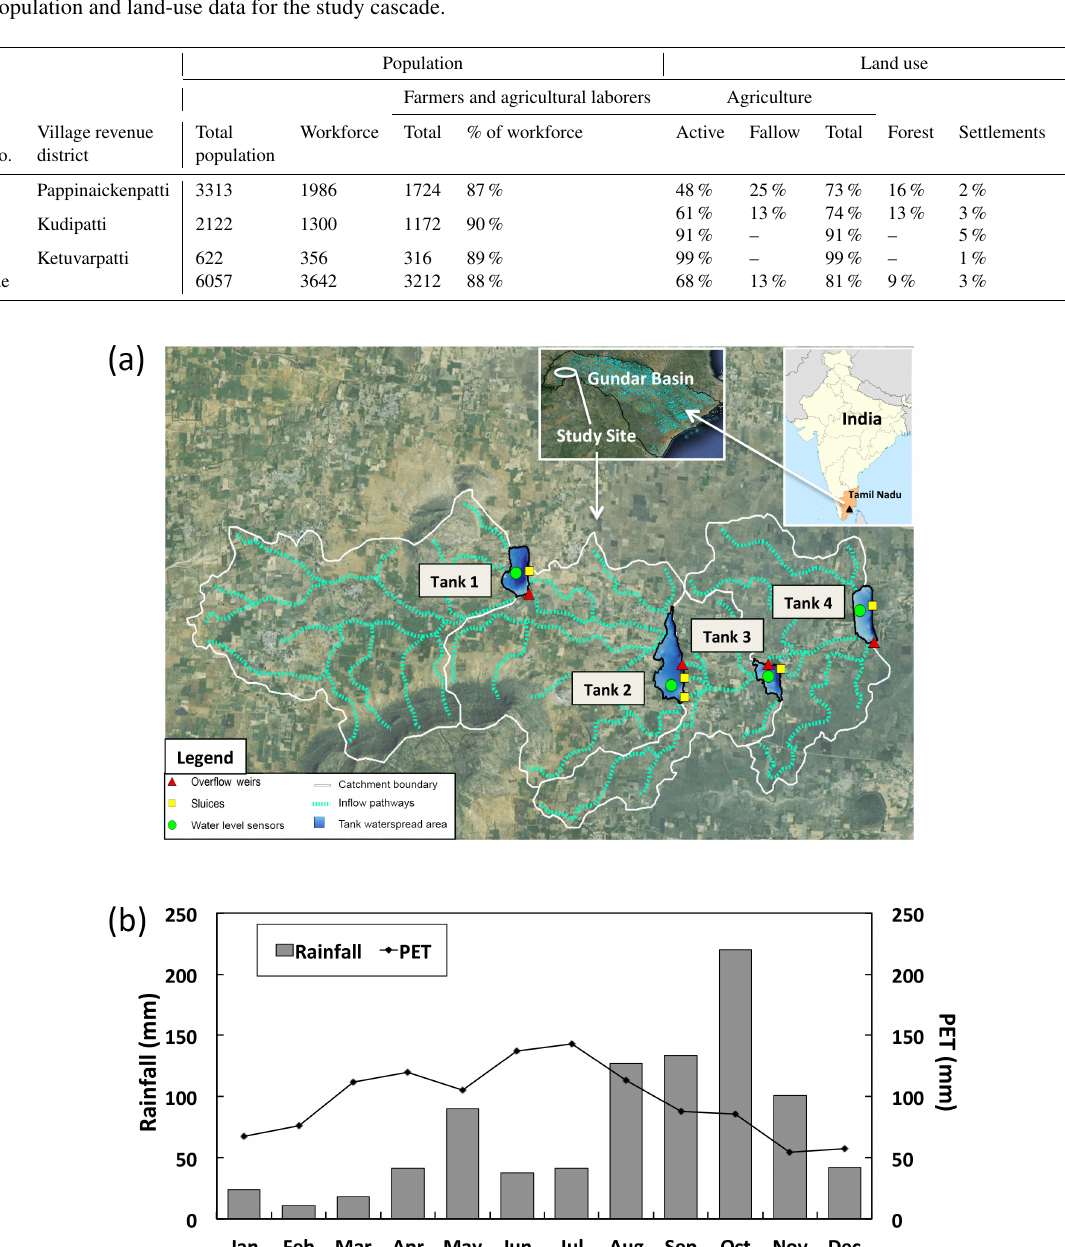
Figure 1. (a) Location of the Thirumal Samudram cascade within Tamil Nadu. The dotted lines indicate flowpaths calculated based on a digital elevation map (DEM) for the area; (b) average rainfall and potential evapotranspiration (PET) (1900–1970) measured at Peraiyur weather station, 10km from the study